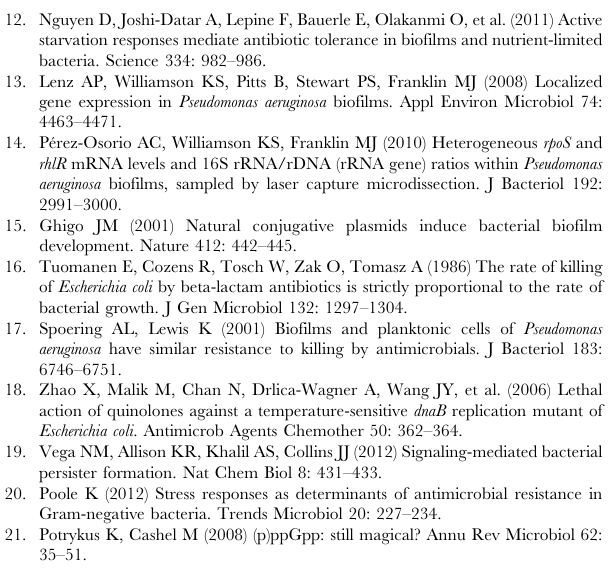
Figure S4 The impact of the SOS response on the ofloxacin tolerance of planktonic bacteria as compared to biofilm. Static cultures were grown for 24 h in M63B1 Gluc in microtiter wells.